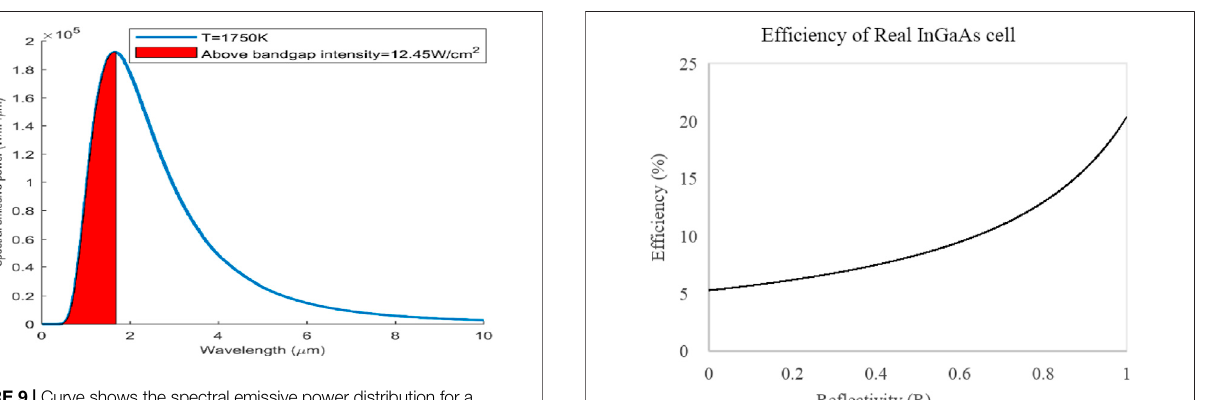
FIGURE 10 | η of a real 0.25 cm 2 InGaAs module (avg EQE = 0.7097) with respect to BSR re fl ectivity R for an emitter temperature of 1750 K. The ef fi ciency of the module increases with the increasing